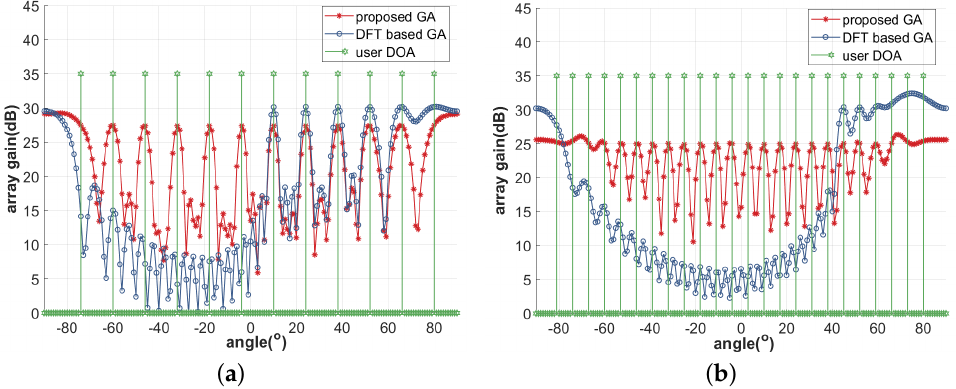
Figure 3. Array gain of massive array based on the proposed GAMP and the DFT-based GAMP: ( a ) on the condition that K = 12, ( b ) on the condition that K = 24.